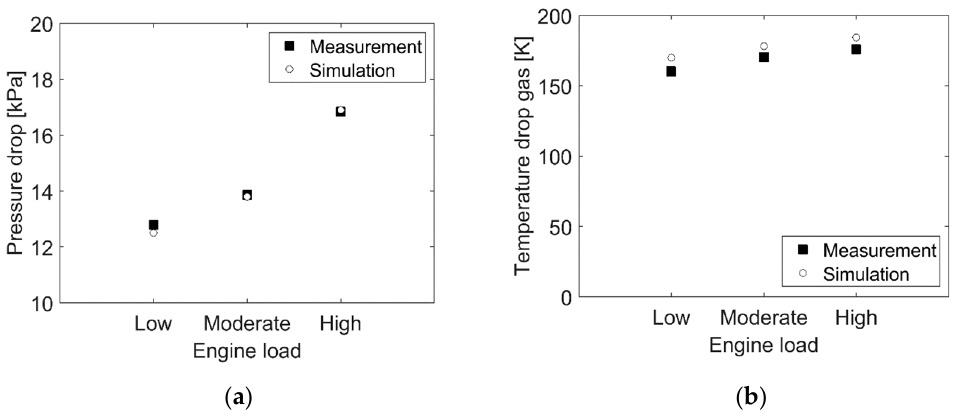
Figure 7. Comparison between experiments and simulation results. ( a ) Pressure drop; ( b ) temperature drop.